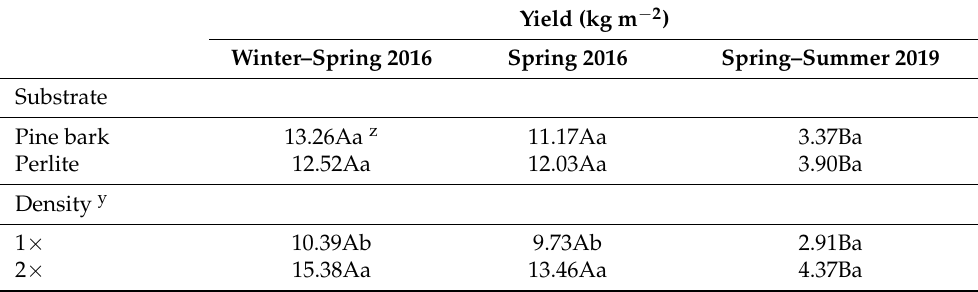
Table 5. Interaction effect of planting density and substrate with season on cucumber fruit yield.